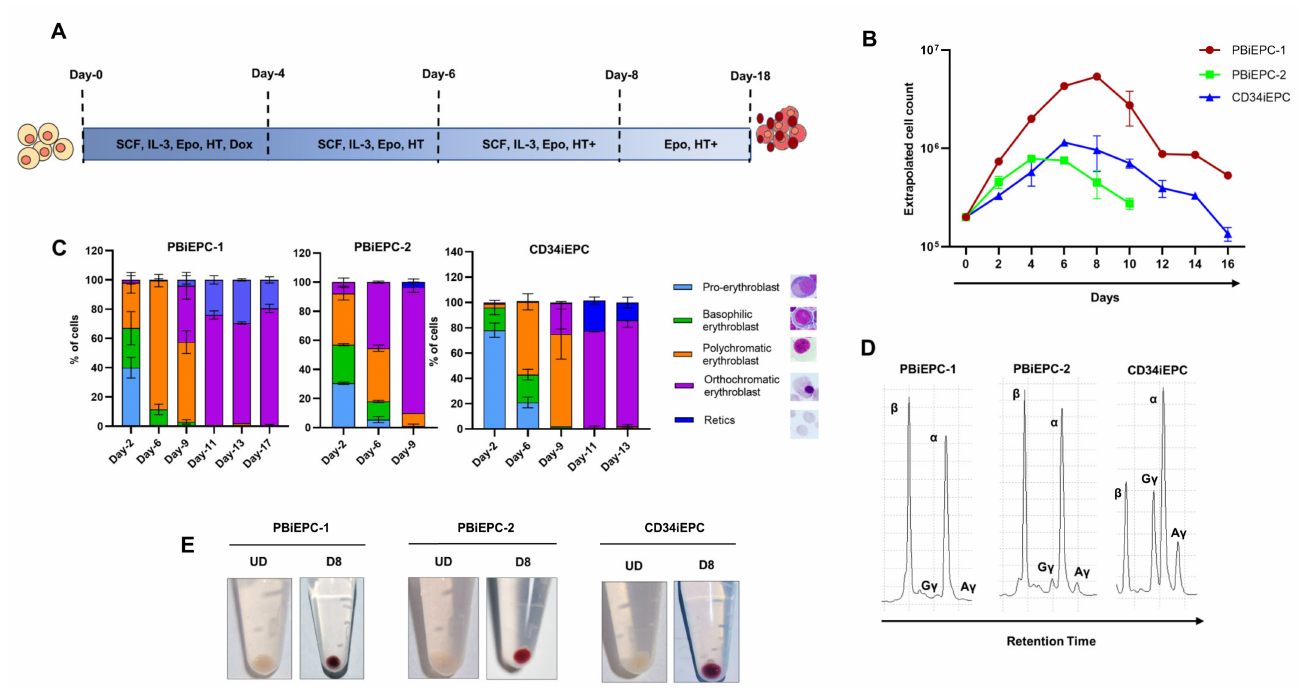
Figure 3. Differentiation of iEPCs. ( A ) Schematic representation of the differentiation protocol for iEPCs. SCF: stem cell factor, IL-3: interleukin-3, Epo: erythropoietin, HT: holotransferrin and dox: doxycycline. HT+ indicates increased holotransferrin concentration in the medium. ( B ) Extrapolated cell count of iEPCs during the different days of erythroid differentiation. ( C ) Morphology of the iEPCs during erythroid differentiation as analyzed using Wright Giemsa staining. ( D ) Representative reverse-phase HPLC analysis of iEPCs showing the contribution of the individual globin chains in the differentiated iEPCs. ( E ) Cell pellet colors of undifferentiated iEPCs (UD) and differentiated iEPCs from day 8 of differentiation